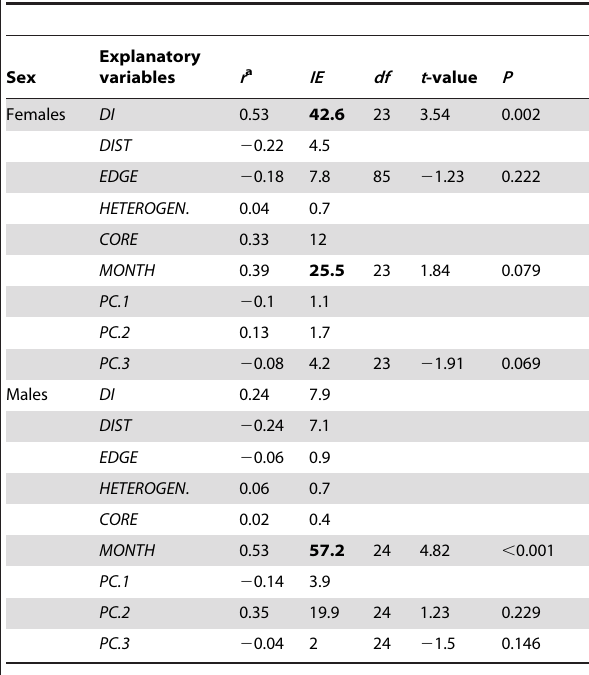
a Pearson’s correlation coefficients ( r ), the independent effect of variables from hierarchical partitioning ( IE ), and results of linear mixed effect model fitting are shown. Degrees of freedom, t -value and P -values are shown for variables that were selected for inclusion in the reduced LMEM using Akaike Information Criterion.